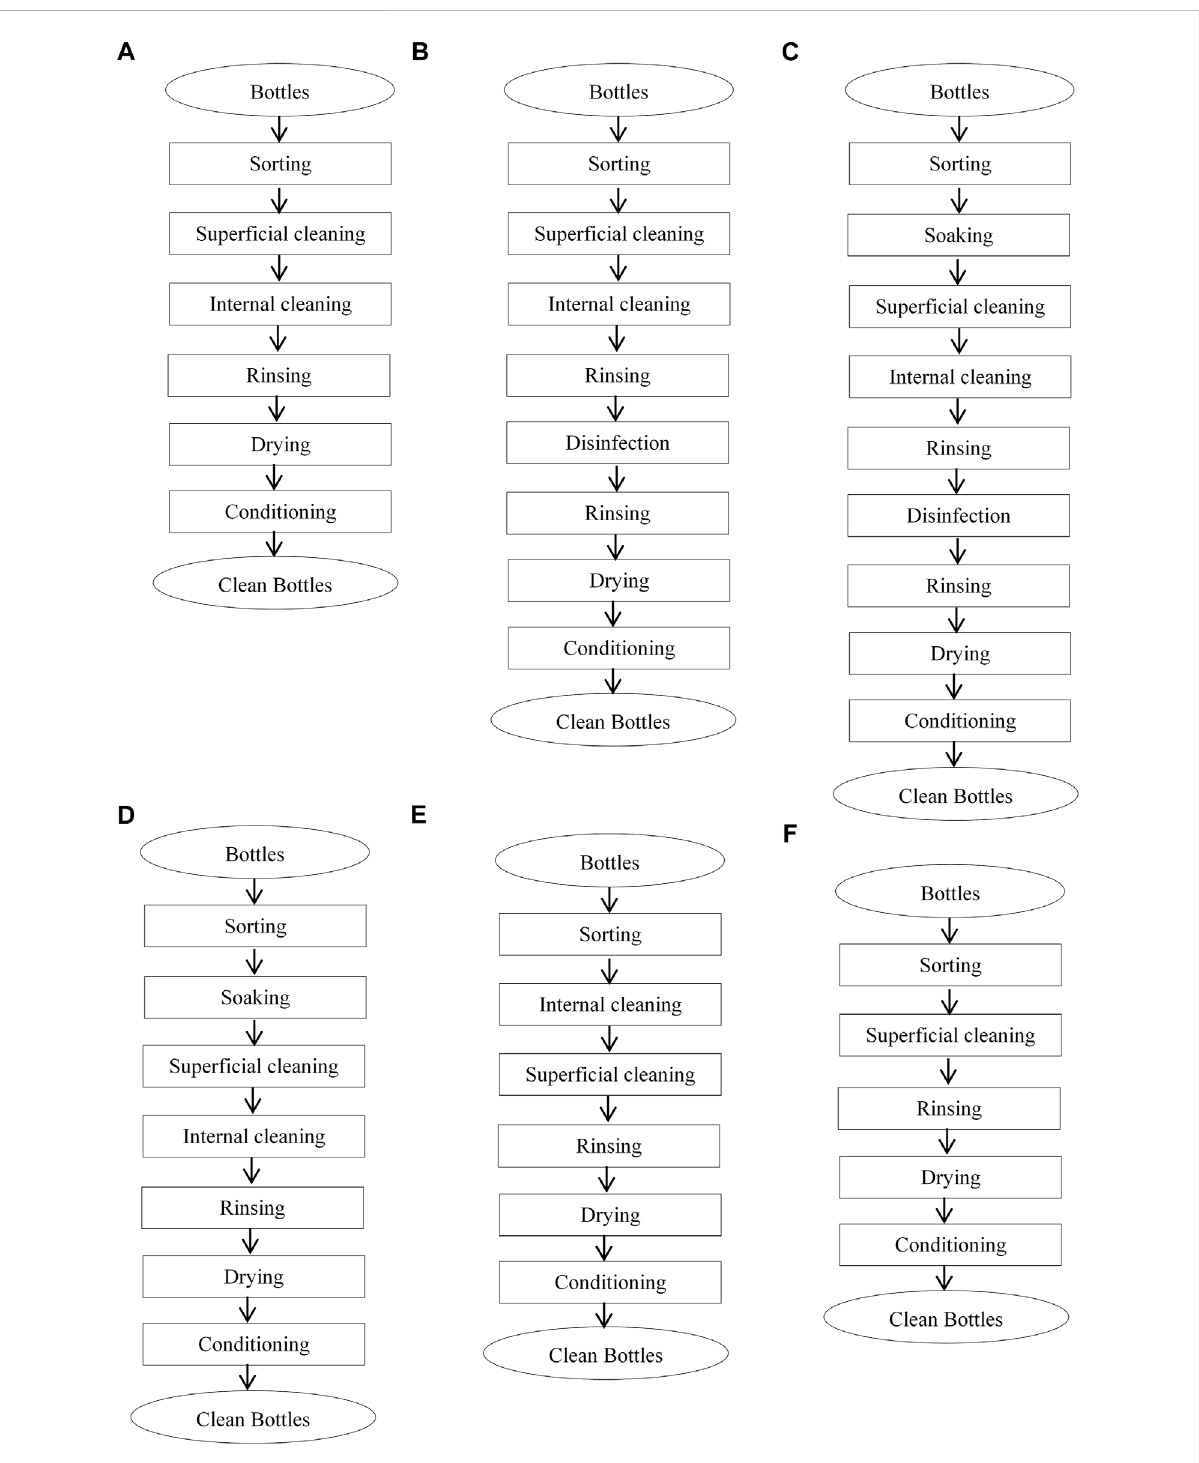
FIGURE 1 The six different cleaning processes of recovered bottles (A – F) obtained from the manufacturers of traditional food